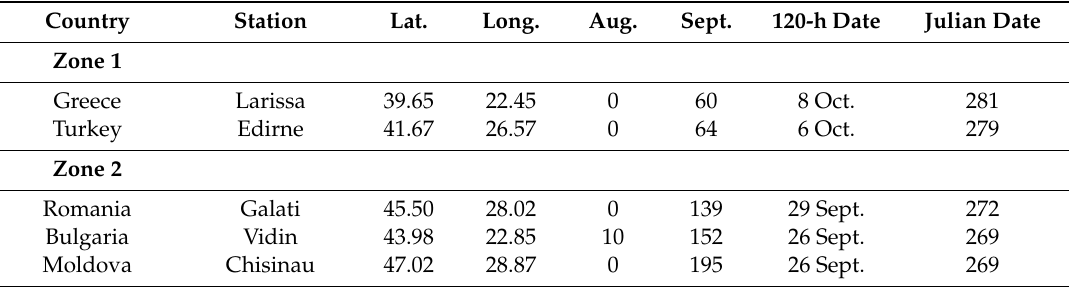
Table 1. Hours below 15 ◦ C in August and September for 21 sites in the Balkan peninsula (country, city, latitude (Lat.) and longitude (Long.)), along with calendar date and Julian Date by which 120 h below 15 ◦ C are accumulated, from latest to earliest date 1